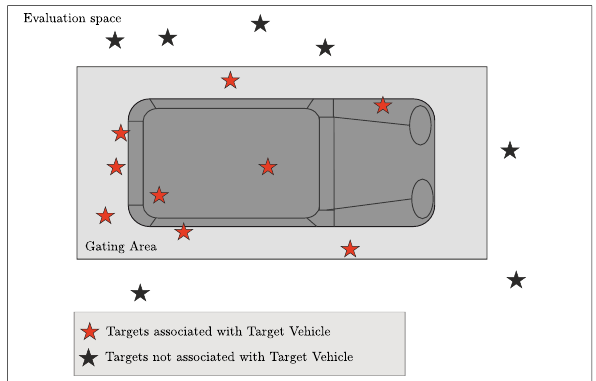
Figure 5. Gating area of the target vehicle with and with not associated reflection points according to [31].